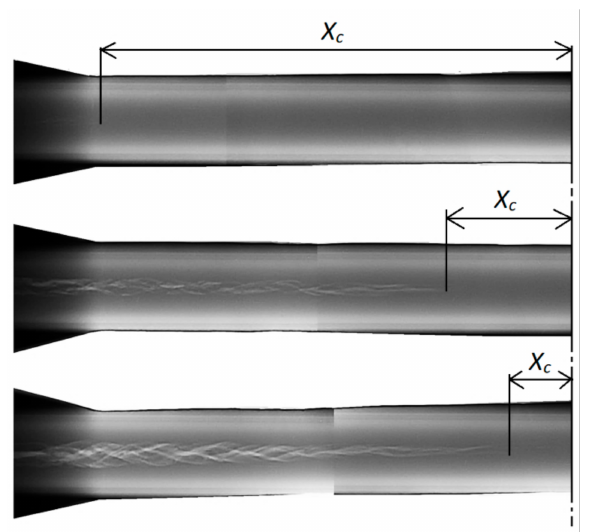
Figure 7. Radiograms of 42CrMo4 steel specimens rolled from billets preheated to (from top to bottom): 1100, 1000 and 900 ◦